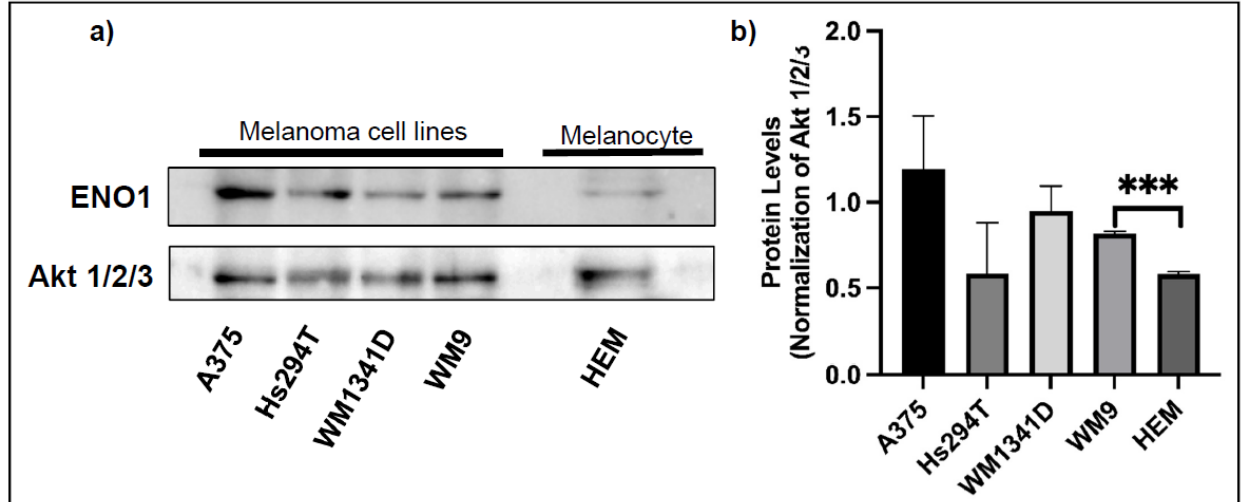
Figure 1. The expression level of ENO1 in the cell lysates from primary melanocytes and melanoma cell lines. Representative Western blots showing ENO1 and Akt 1/2/3 expression (for normalization) in protein lysates obtained from the primary human melanocytes (HEM) and indicated melanoma cell lines ( a ). Densitometric ENO1/Akt ratios are shown as mean values (n = 3 except for HEM, n = 2) ± standard error of the mean (SEM) ( b ). The significance level was set at p = 0.001–0.0001 (***).